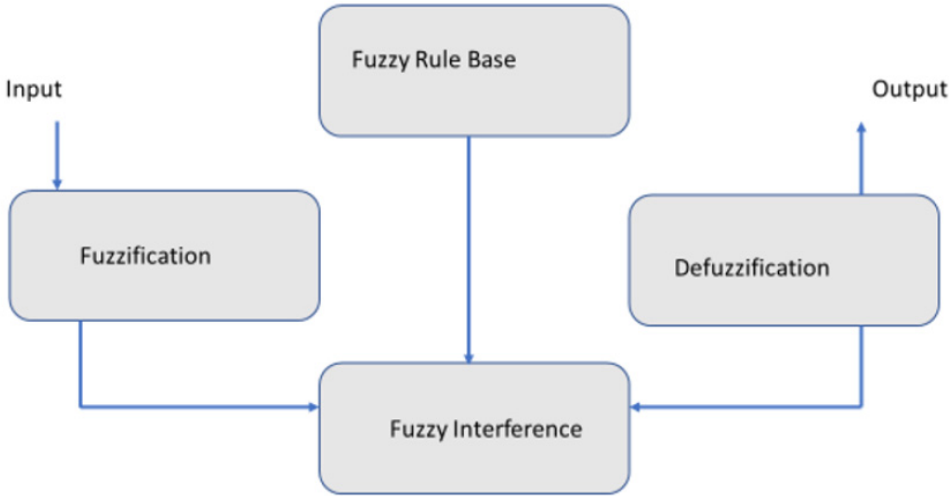
Figure 2. Architecture of the fuzzy system.